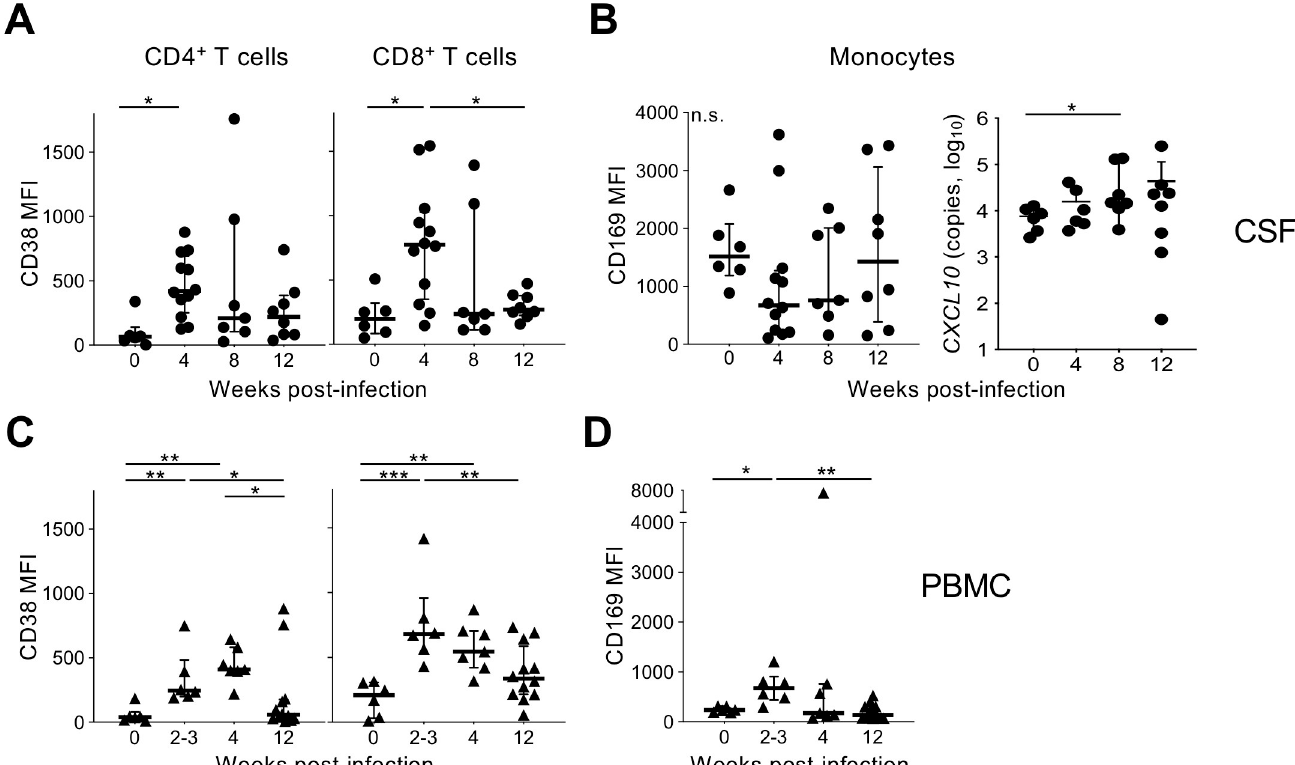
Fig 3. Cellular activation in CSF and PBMC during acute SHIV infection. T cell and monocyte activation assessed by surface staining flow cytometry for CD38 and CD169, respectively, following SHIV infection in macaques. (A) CSF CD4+ and CD8+ T cell CD38 expression, reported as the median fluorescent intensity (MFI), is shown at the indicated weeks PI. (B) CSF monocyte CD169 MFI and CXCL10 gene expression (copies per 10 6 cells) measured by RT-qPCR is shown at the indicated weeks PI. (C) PBMC CD4+ and CD8+ T cell CD38 surface protein expression and (D) PBMC monocyte CD169 expression is shown at the indicated weeks PI. Bars and whiskers indicate median and interquartile range values, respectively. Significant differences by Mann-Whitney test are indicated as follows: � , P < 0.05; �� , P < 0.01; ��� , P <